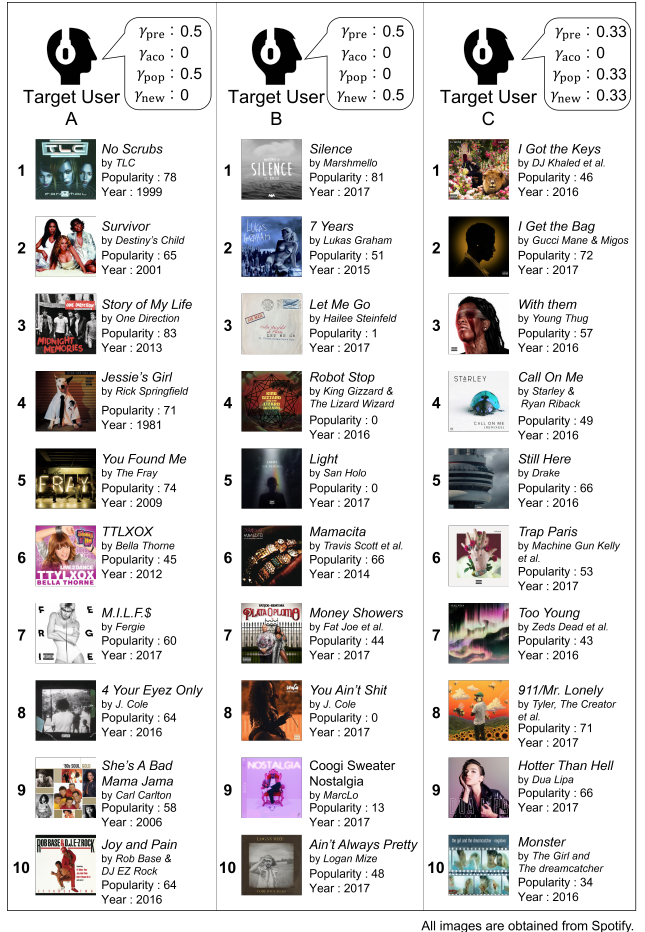
Figure 2. The examples of the generated playlists. The playlists generated for target users A and B contain many popular and new music tracks, respectively. Furthermore, our model generated a playlist consisting of both many popular and new music tracks for the target user